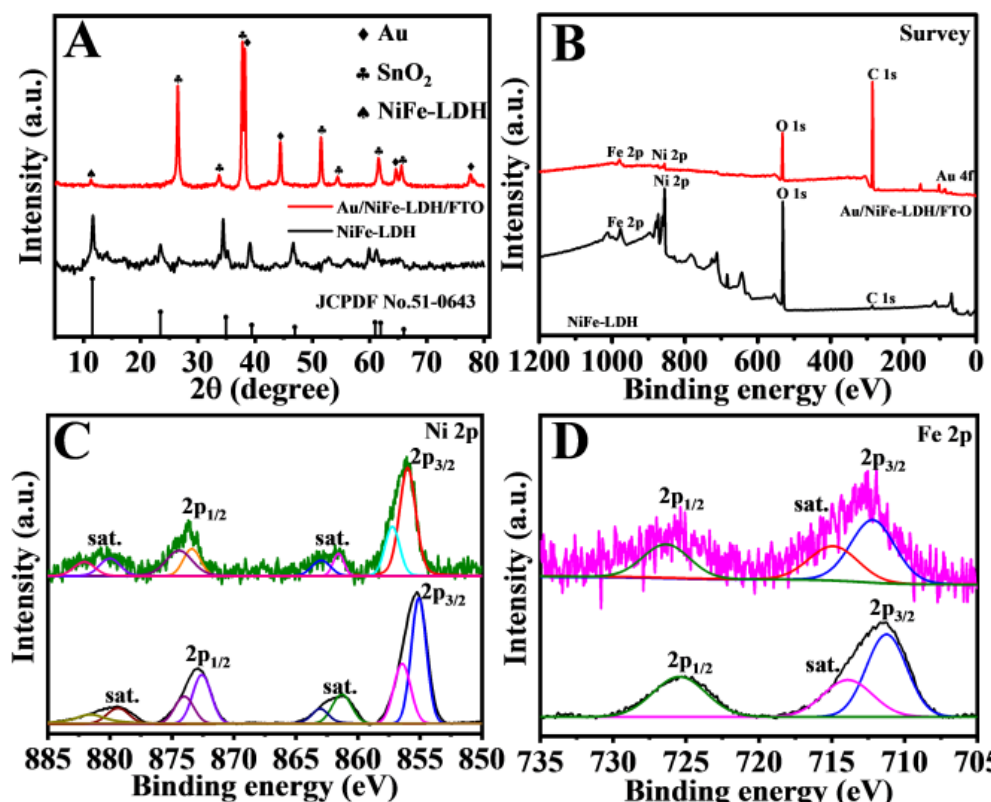
Figure 3. XRD image ( A ), XPS ( B ) survey spectra, Ni 2p ( C ), and Fe 2p ( D ) of Au/NiFe-LDH/FTO and NiFe-LDH.